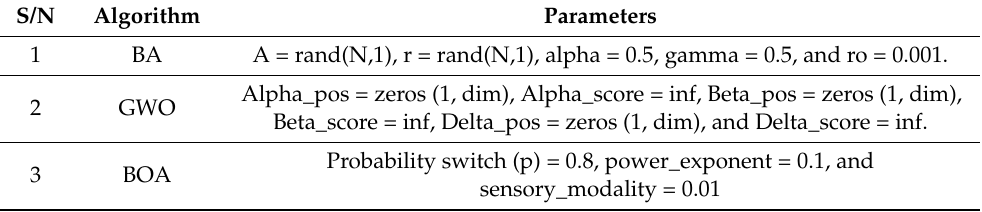
Table 11. Algorithm-specific parameters.